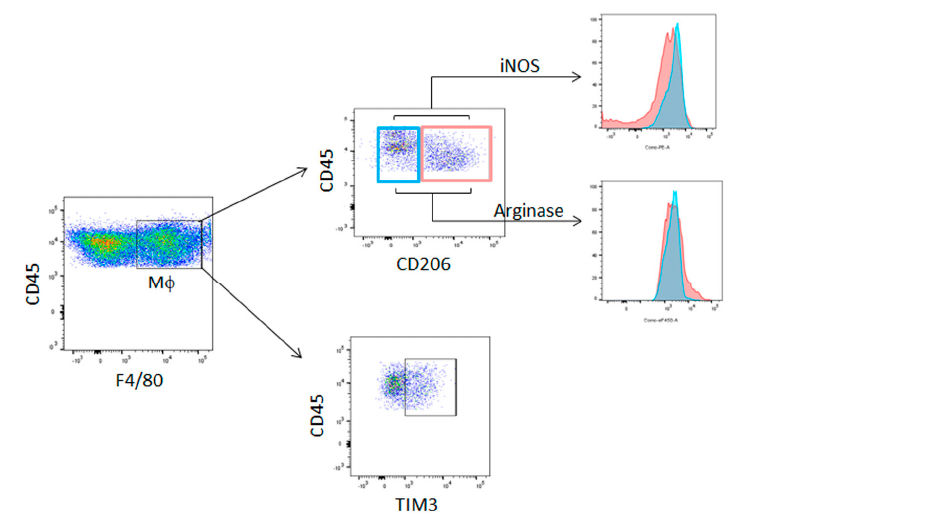
Figure 1. The gating strategy for flow cytometry analysis. A live cell gate was first applied on the basis of forward (FSC) and side (SSC) scatter, followed by doublets exclusion. Further analysis of living cells was achieved on the basis of aqua staining (Zombie dye). The expression of the different markers was performed in the Zombieneg CD45 + cells population.